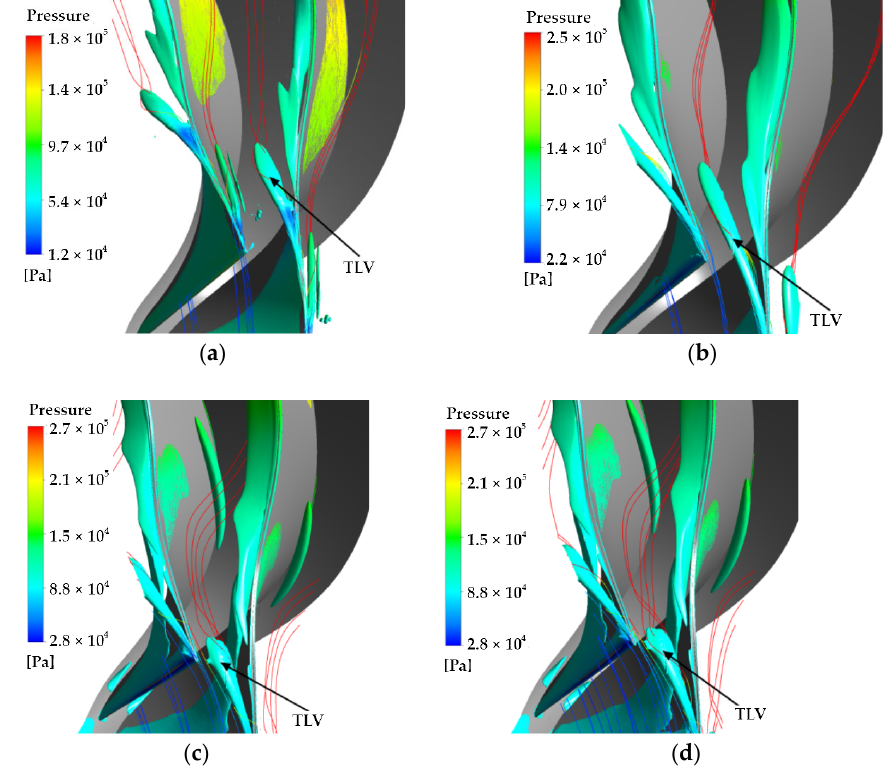
Figure 5. Trajectory variations of the TLVs under different working conditions. ( a ) S1: large margin point; ( b ) S2: design point; ( c ) S3: quasi ‐ stall point; ( d ) S4: near ‐ stall point.